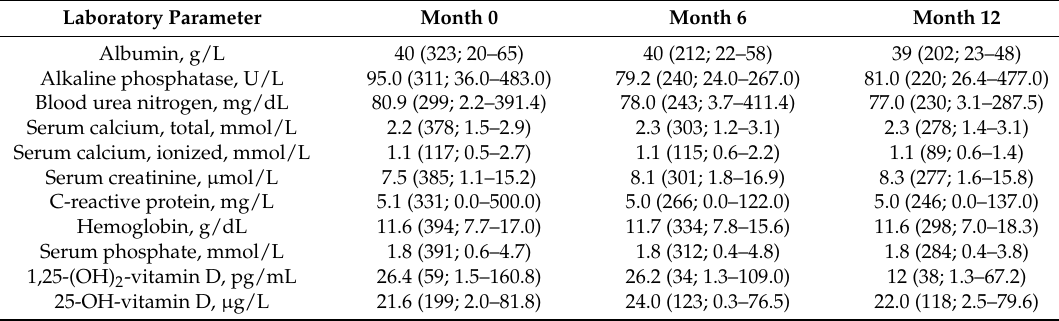
Table 13. Relevant laboratory data from dialysis patients *.